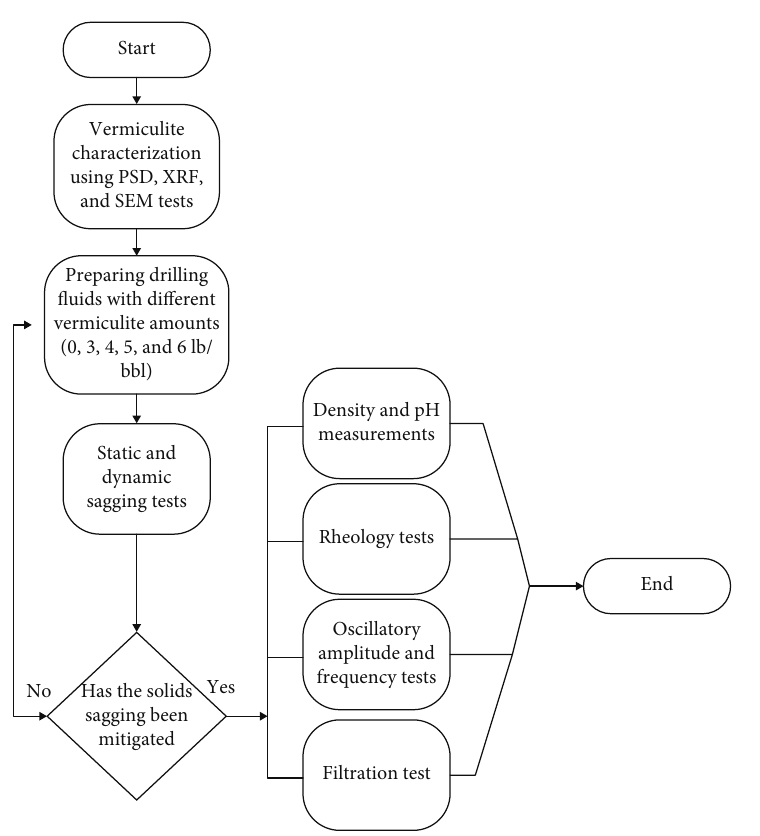
Figure 3: Experiments methodology.